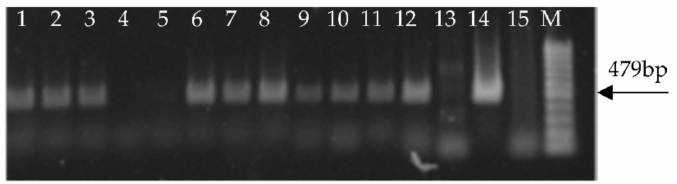
Lanes 4–5 negative samples; Lane 14, positive control; Lane 15, negative control (water and PCR mix), M, marker (GeneRuler 100 bp DNA Ladder).